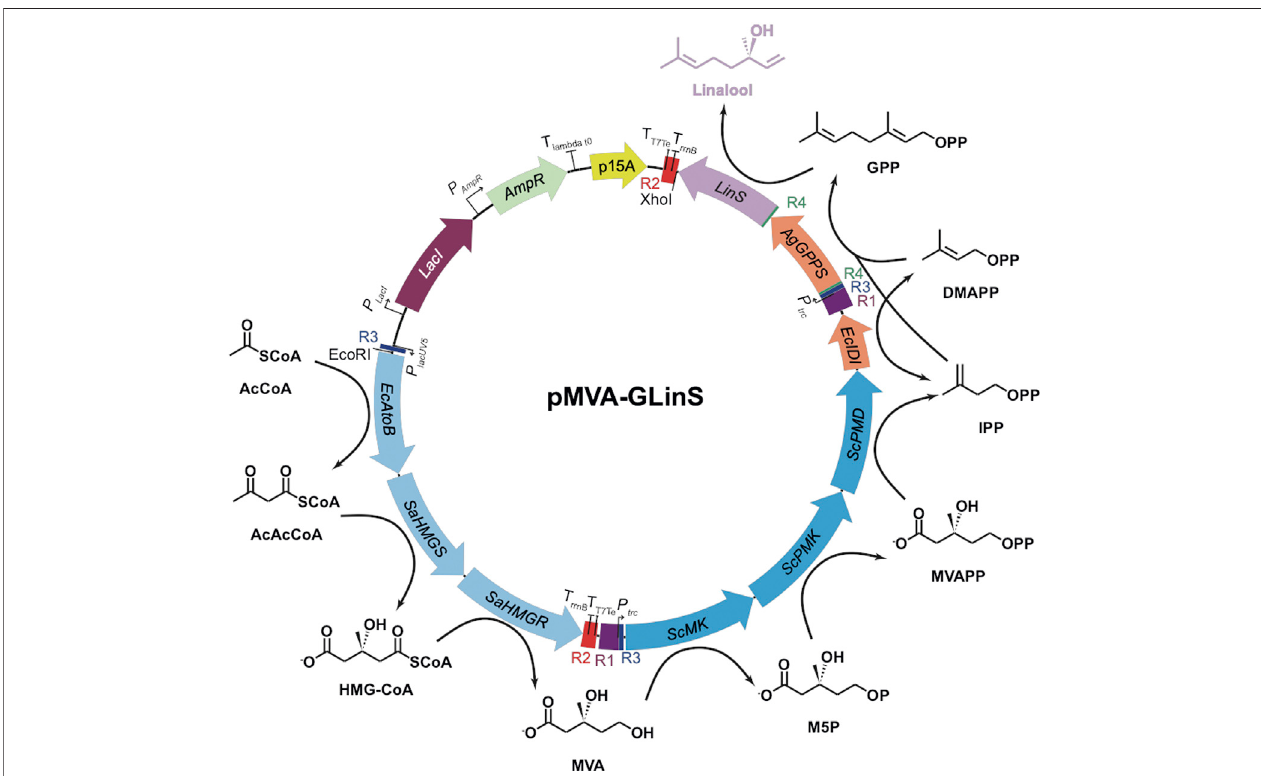
FIGURE1| Recombinantpathwayforlinaloolproductionin E.coli (Leferinketal.,2016;Ferrazetal.,2021).Upper(MevT)andlower(MevB)MVApathwayenzymes areshowninlightanddarkblue,respectively(Alonso-Gutierrezetal.,2013).Enzymes:AgGPPS=geranylpyrophosphatesynthase;EcAtoB=acetoacetyl-CoAthiolase; EcIDI = isopentenyl diphosphate isomerase; LinS = linalool synthase; SaHMGR = HMG-CoA reductase; SaHMGS = HMG-CoA synthase; ScMK = mevalonate kinase; ScPMD = phosphomevalonate decarboxylase and ScPMK = phosphomevalonate kinase. Chemicals: AcAcCoA = acetoacetyl-CoA; AcCoA = acetyl-CoA; DMAPP = dimethylallyl diphosphate; GPP = geranylpyrophosphate; HMG-CoA = hydroxymethylglutaryl CoA; IPP = isopentenyl diphosphate; M5P = mevalonate-5- phosphate; MVA = mevalonate; MVAPP = mevalonate